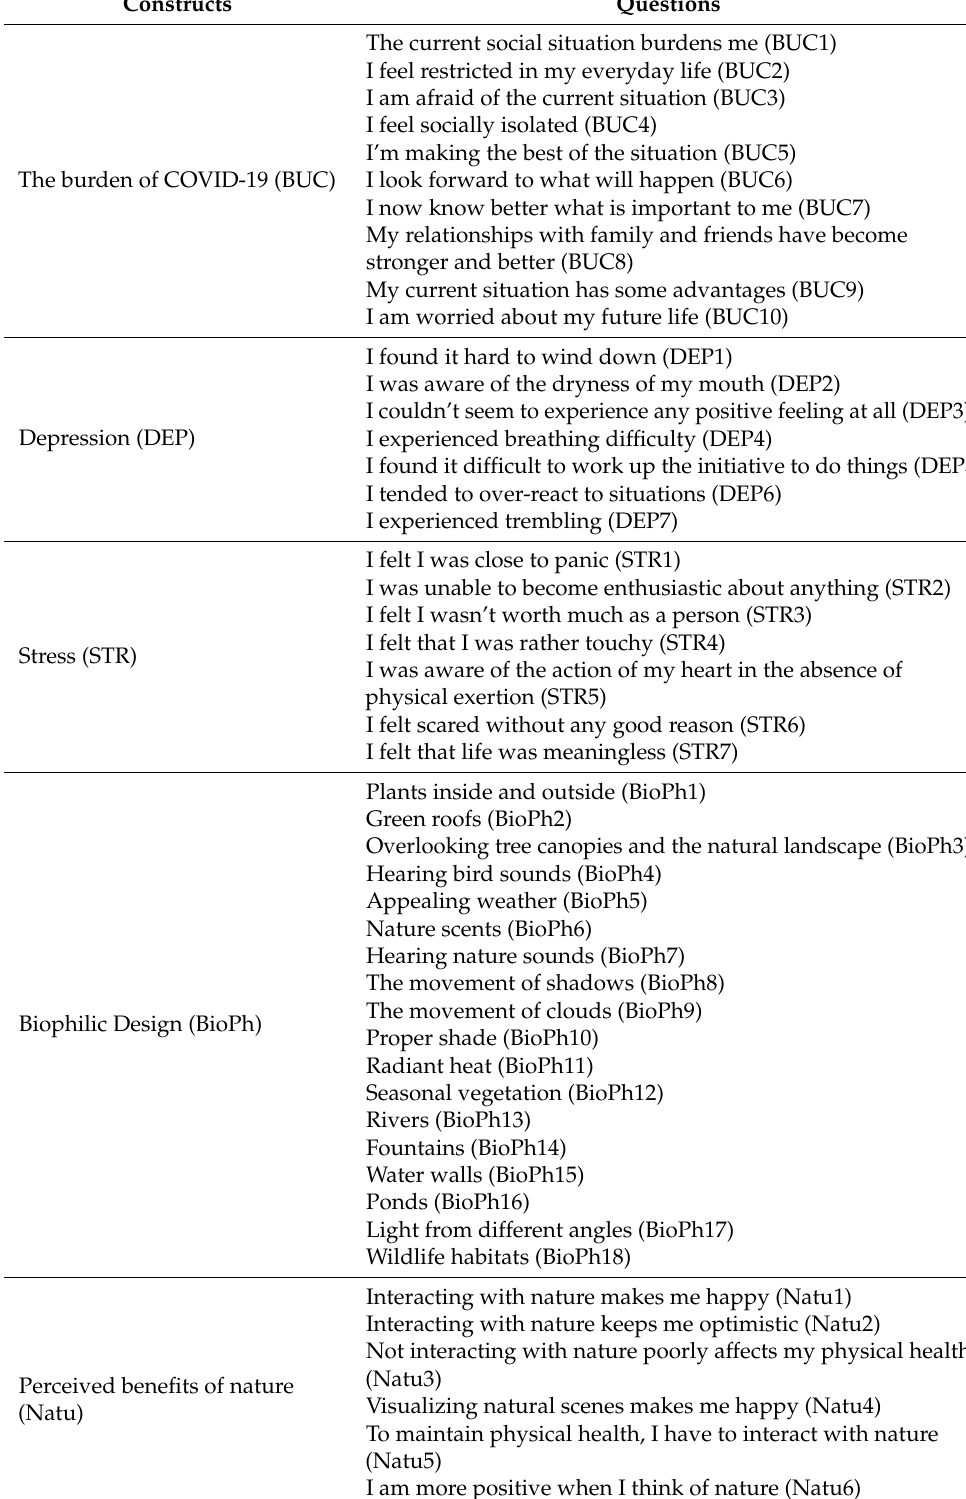
Table 1. Measurement constructs and